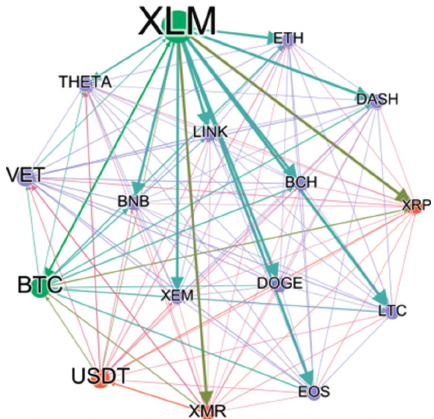
Figure 32: Risk spillover under